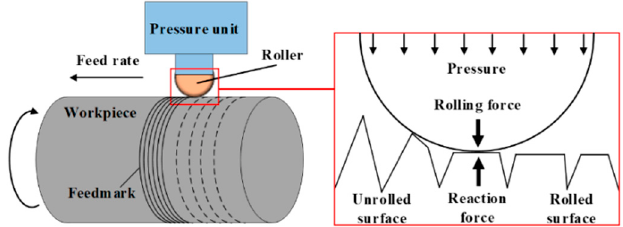
Figure 1. Surface smoothing mechanism by LPB